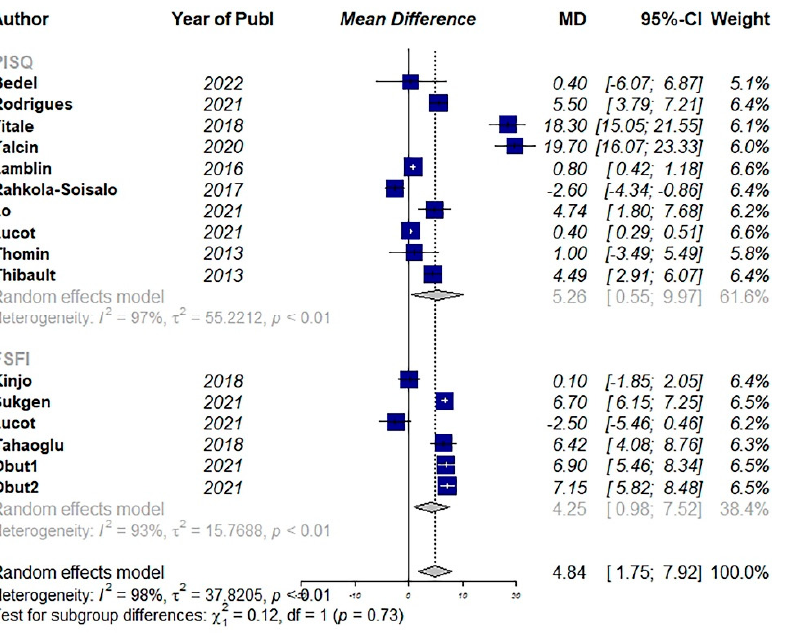
Figure 7. Pooled mean difference of the effect of surgical intervention (vaginal and abdominal surgery) on total quality of sexual activity. (PSIQ: Pelvic Organ Prolapse/Urinary Incontinence Sexual Function Questionnaire, FSFI: Female Sexual Function Index) [9,20,24,37,39,42,43,55,56,61,75,76,85].